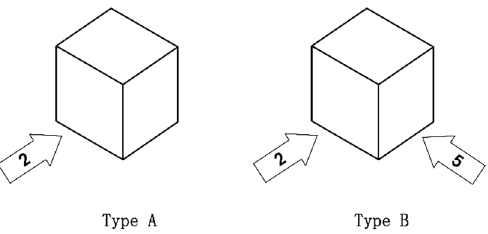
Figure 10. Two types of parallel machining orientation combinations are represented by A and B, respectively.